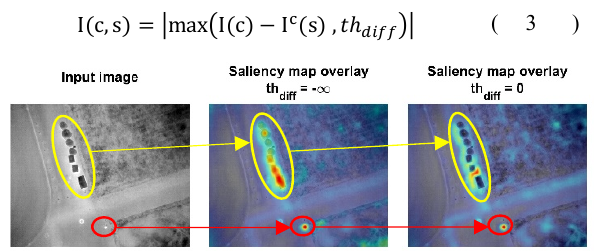
Figure 2: Influence of 𝑡ℎ (cid:3031)(cid:3036)(cid:3033)(cid:3033) on saliency computation. The sali- ency map overlay, shown in the centre and right images has the following interpretation: no colour represents zero saliency, blue-greenish represents weak saliency, red represents high sali-